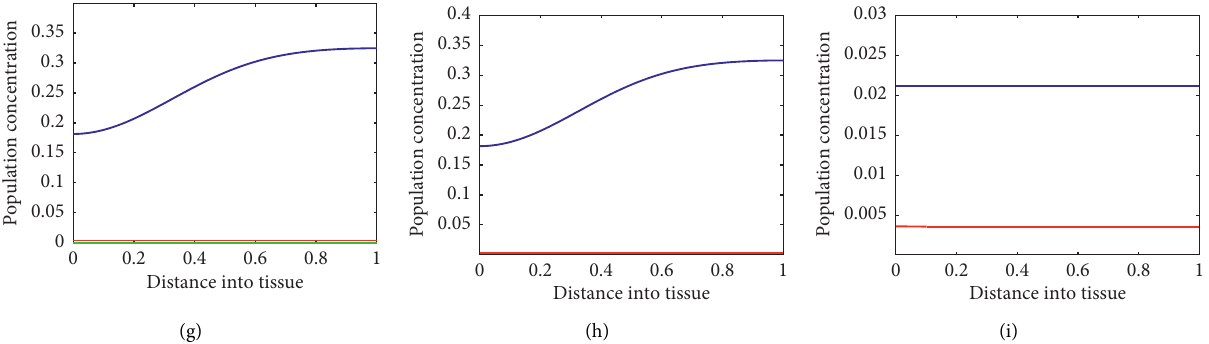
Figure 5: Evolution profiles of the effector cell (blue), the cancer cell (green), and IL-2 (red) concentrations for the cancer cell random � 0 . 0000199. (a) t � 0.1. (b) t � 0.5. (c) t � 1. (d) t � 1.5. (e) t � 1.7. (f) t � 3. (g) t � 7. (h) t � 10. (i) t � motility coefficient d 2